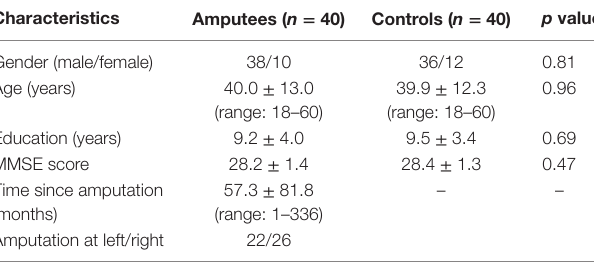
TaBle 1 | Demographic data of the